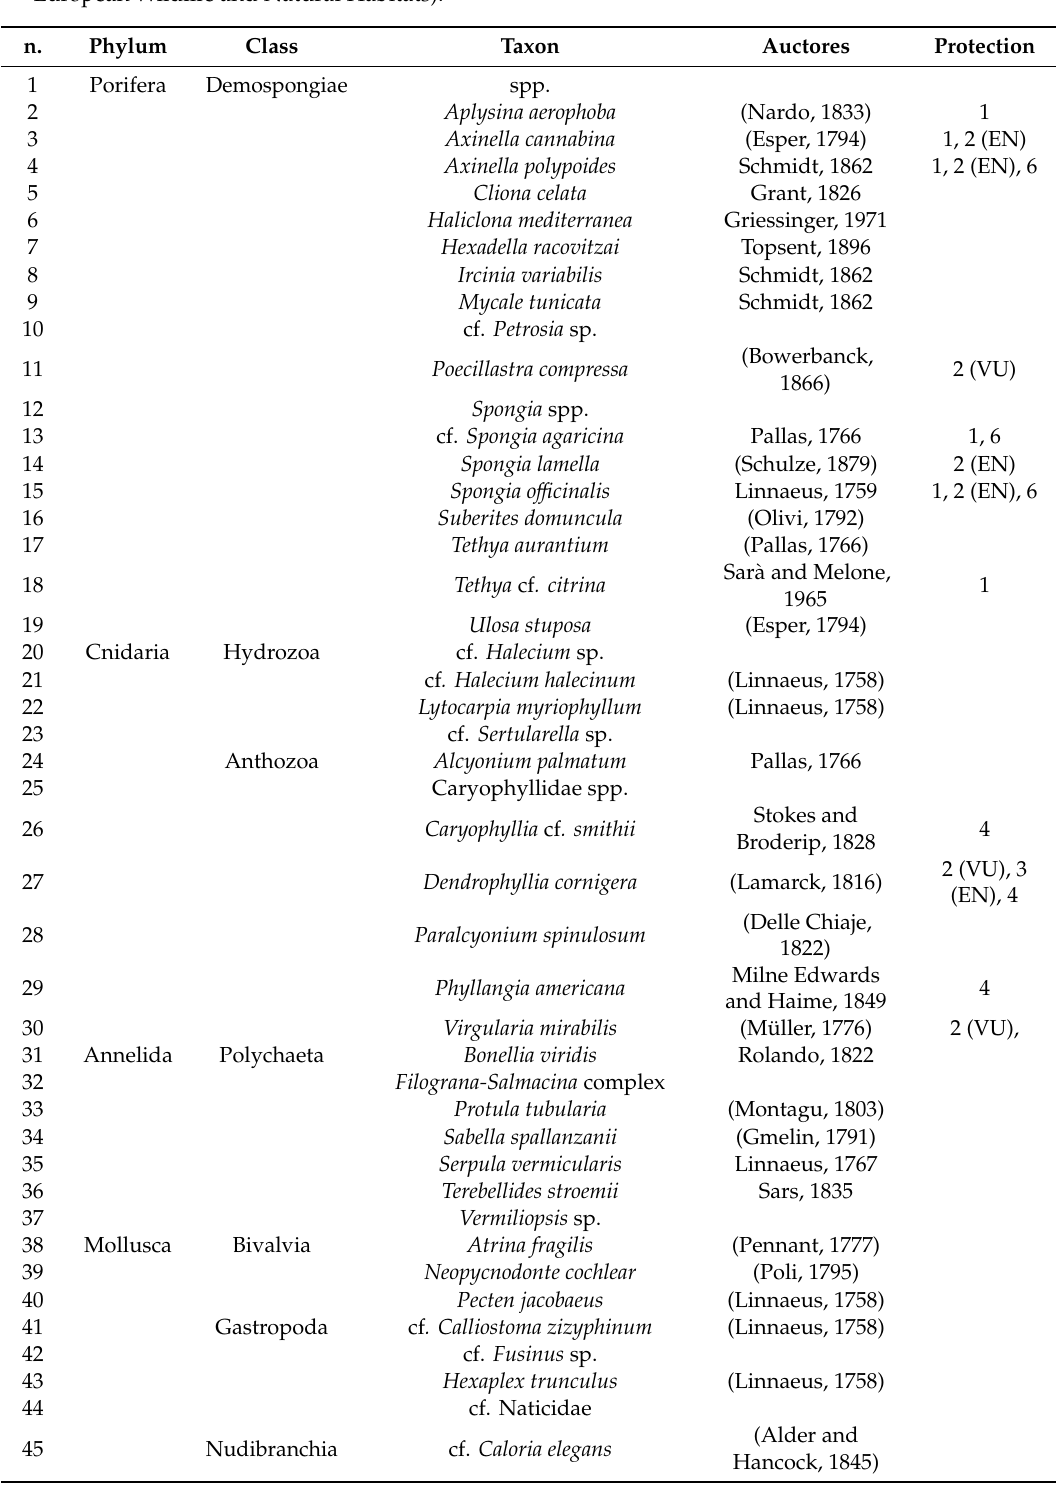
Table 2. Living macro-organisms observed in the ROV surveyed areas. The numbers indicate the legal instruments under which the species are protected: 1—SPAMI Annex II, III (Specially Protected Areas of Mediterranean Importance); 2—Italian Red List IUCN; 3—Red List IUCN; 4—CITES Appendix II (Convention on International Trade in Endangered Species of Wild Fauna and Flora); 5—Habitat Directive Annex II, IV, V; 6—Bern Convention, Appendix II, III (Convention on the Conservation of European Wildlife and Natural